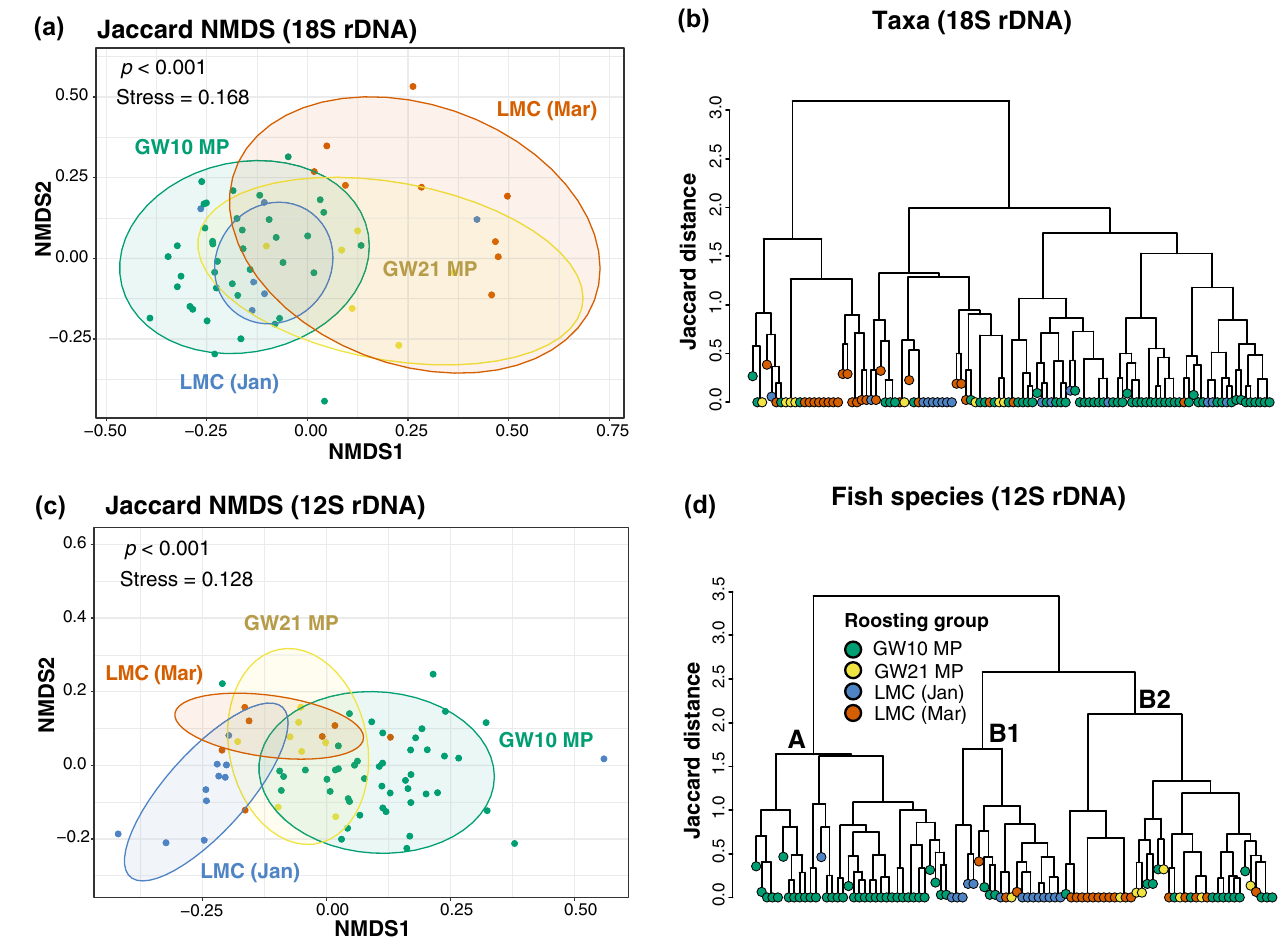
Figure 6. Incidence-based Jaccard dissimilarities of the dietary taxa compositions between different roosting groups of Platalea minor . (a,c) Nonmetric multidimensional scaling (NMDS) and (b,d) hierarchical clustering dendrograms showed the differences in dietary compositions of taxa (a,b) and fish species (c,d) between the roosting groups identified using 18S and 12S rDNA markers, respectively. Stress level of NMDS analysis and statistically significant differences examined by permutational ANOVA test ( p < 0.001) were indicated. See Fig. 3 for abbreviations. The abundance-based figures and related tables are available in the Supplementary Fig. S2, Tables S5b, S7, S9b, and